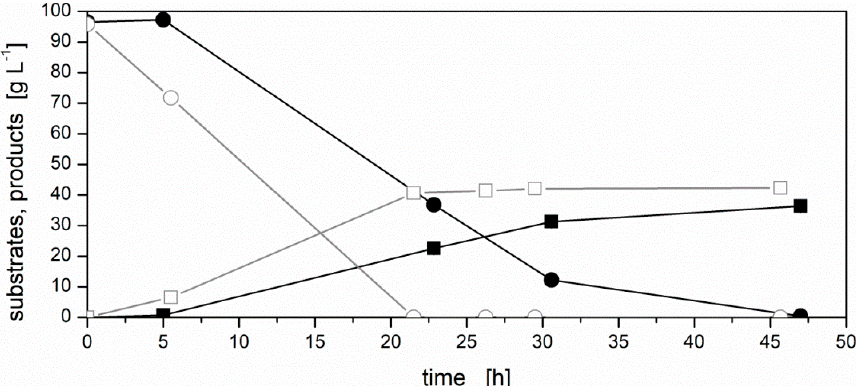
Figure 2. Cultivation of B. vallismortis B-14891 in a 250 mL reactor with glucose (grey, open symbols) and xylose (black, closed symbols) as sole carbon source in modified basal media; substrate concentration (circle, grams per litre), product concentration (2,3-BDO + acetoin, square, grams per litre). Cultivation was performed at 37 °C, with a filling volume of 100 mL and an aeration rate of 25 sL h − 1 with air. Agitation speed was 600 rpm for glucose cultivation and 300 rpm for xylose cultivation. Initial pH for glucose was 6.6 ± 0.1 and pH control at pH 5.0 with 2 M NaOH during the cultivation. Initial pH for xylose was 6.6 ± 0.1 and pH control at pH 5.8 with 4 M NaOH during the cultivation.